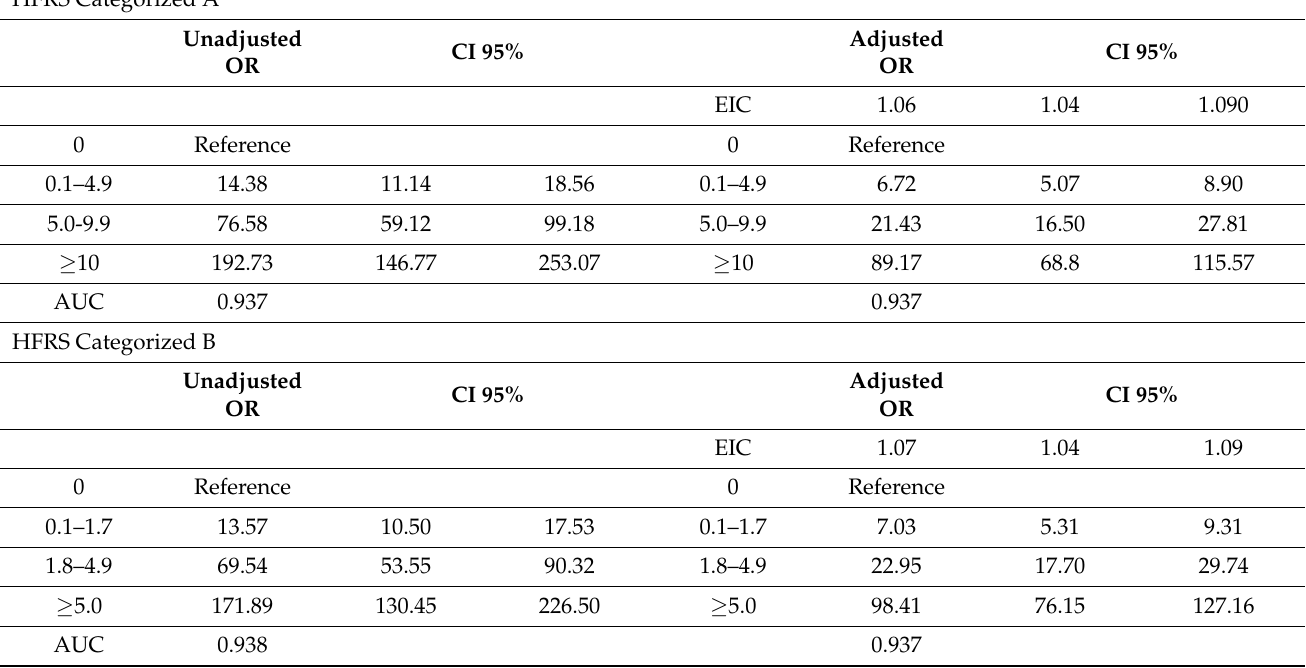
Table 6. Adjusted and Unadjusted Multivariable logistic models for the incidence of postoperative sepsis for Elixhauser and HFRS and predictive capacity estimated by Area Under the Curve of the different